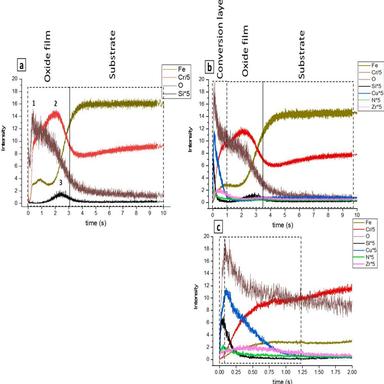
The GDOES depth profiles of the blank sample (a), the conversion treated sample (b), and its magnified profile until 2 s of sputtering (c).